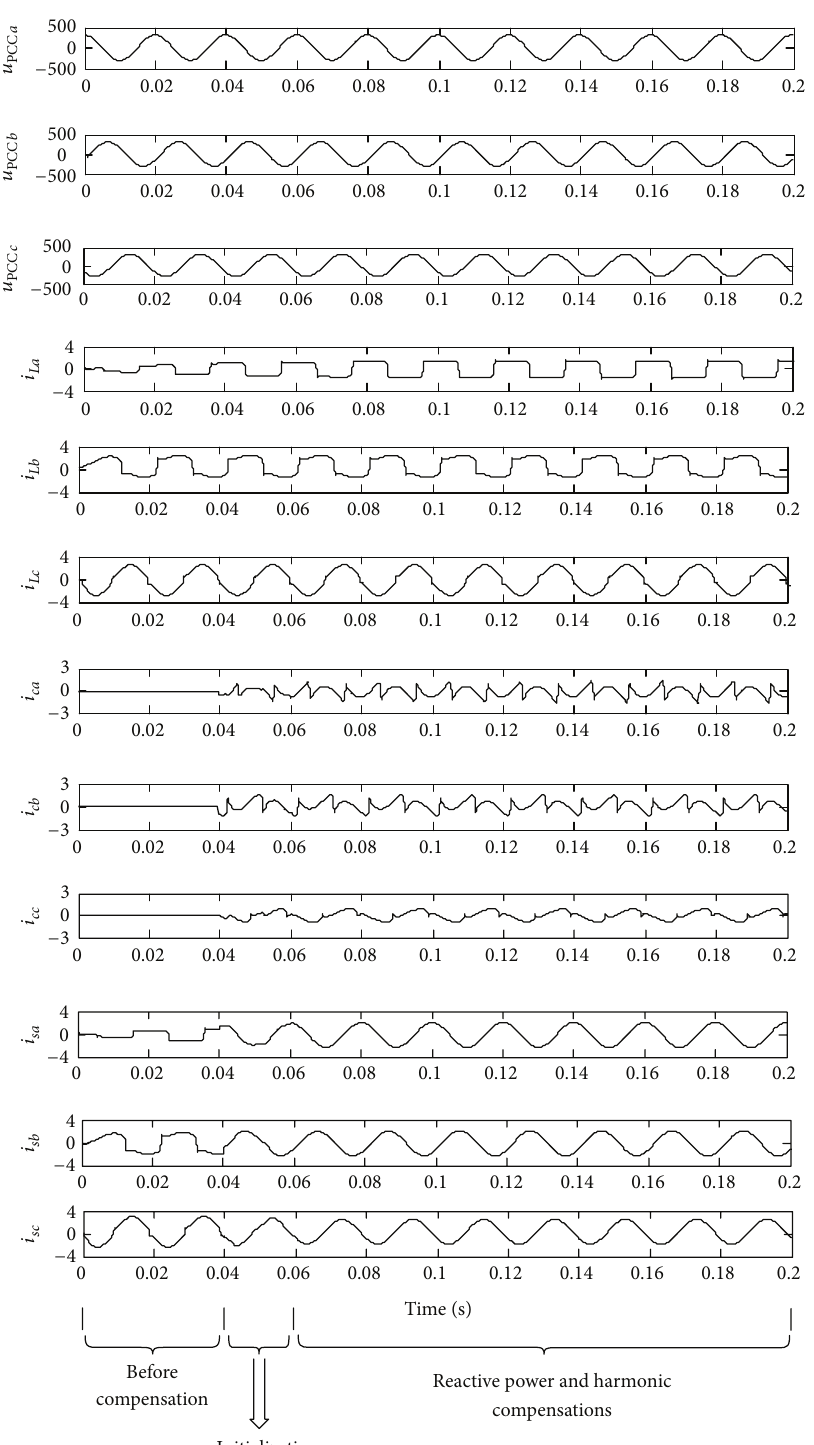
Figure 8: The simulation results using PQF algorithm for ideal shunt active power filter with unbalanced